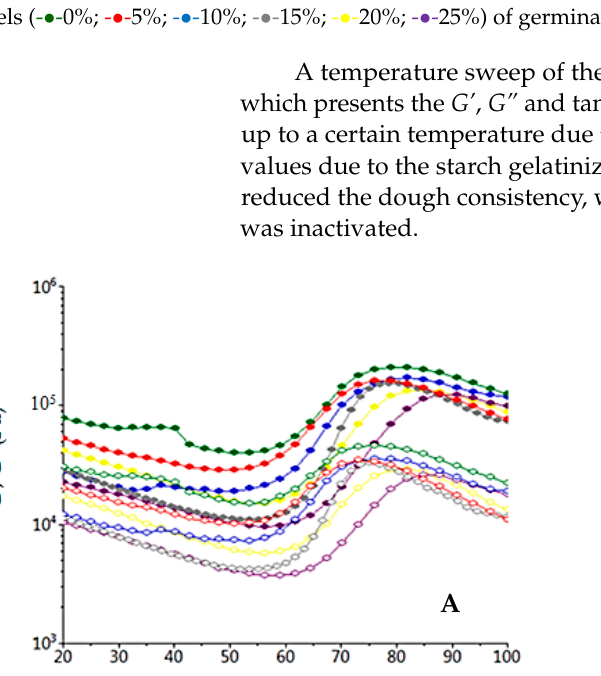
Figure 2. Evaluation with temperature of the G ′ values (open symbols), G ′′ (solid symbols) ( A ) and tan δ ( B ) for the samples with different levels (- ● -0%; - ● -5%; - ● -10%; - ● -15%; - ● -20%; - ● -25%) of germinated bean flour additions.